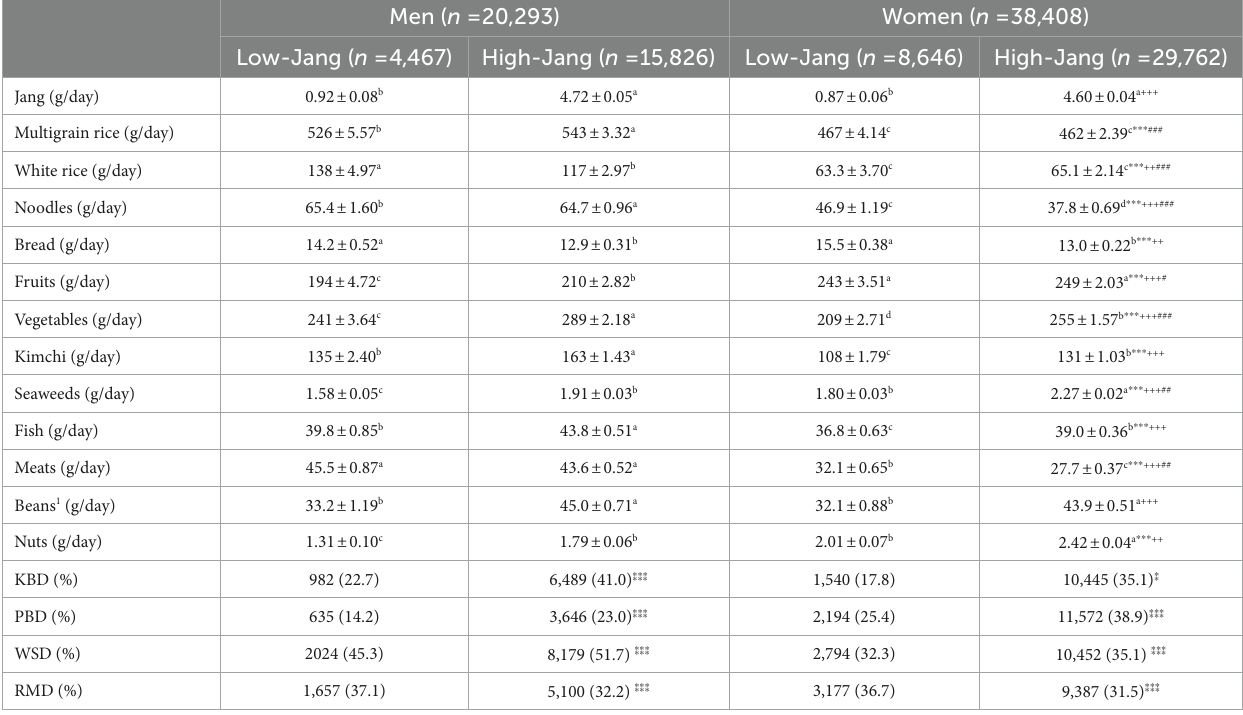
Values represents means and standard deviations for continuous variables and numbers and percentage for categorical variables. 1 Beans without Jang intake. The cutoffs of Jang intake were <1.9 g/day. *** Significant differences by genders at p < 0.001. +++ Significant differences by Jang intake at p < 0.01 and +++ at p < 0.001. # Significant interaction between genders and Jang intake